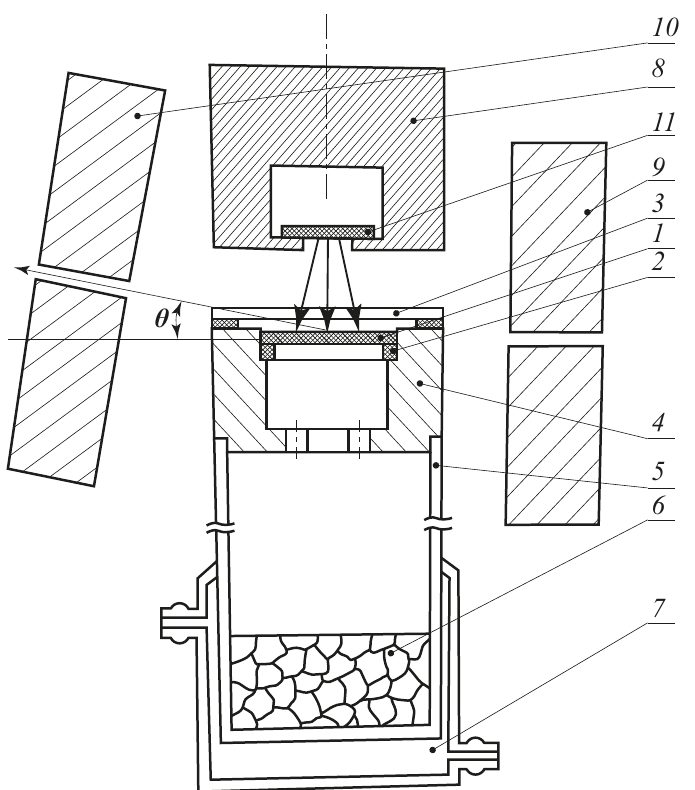
Figure 1. Setup for positron angular correlation curves measurement: 1—studied polymer film, 2—thin aluminum ring, 3—mica window, 4—chamber, 5—glass vessel, 6—vapour source, 7—jacket, 8—lead shielding, 9,10—fixed and movable lead collimators, 11—positron source.